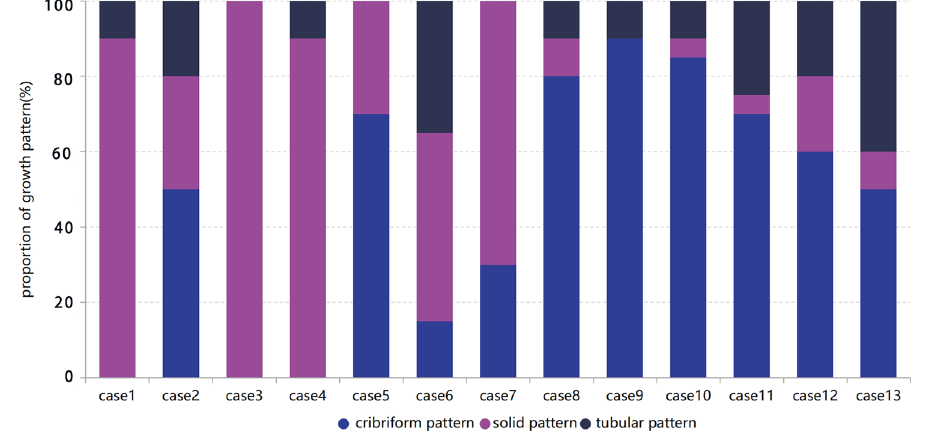
Figure 1. Histogram showing proportion of morphological growth pattern in AdCC patients. Case 1–7 is SB-AdCC group and Case 8–13 is C-AdCC group.